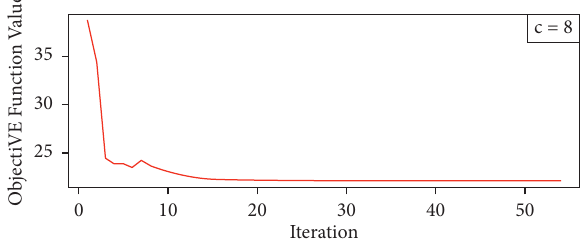
Figure 13: Convergence study on the predicting